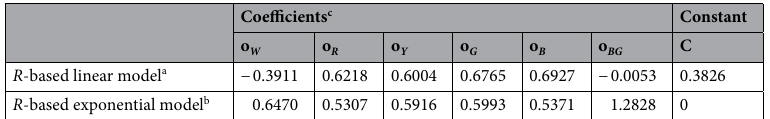
Table 3. Optimized coefficients and constant in three-dimensional color prediction models. a R -based linear model: see Eq. (7). b R -based exponential model: see Eq. (8). c Coefficients: o W for white yarn; o R for red yarn; o Y for yellow yarn; o G for green yarn; o B for blue yarn; o BG for background (white tile).